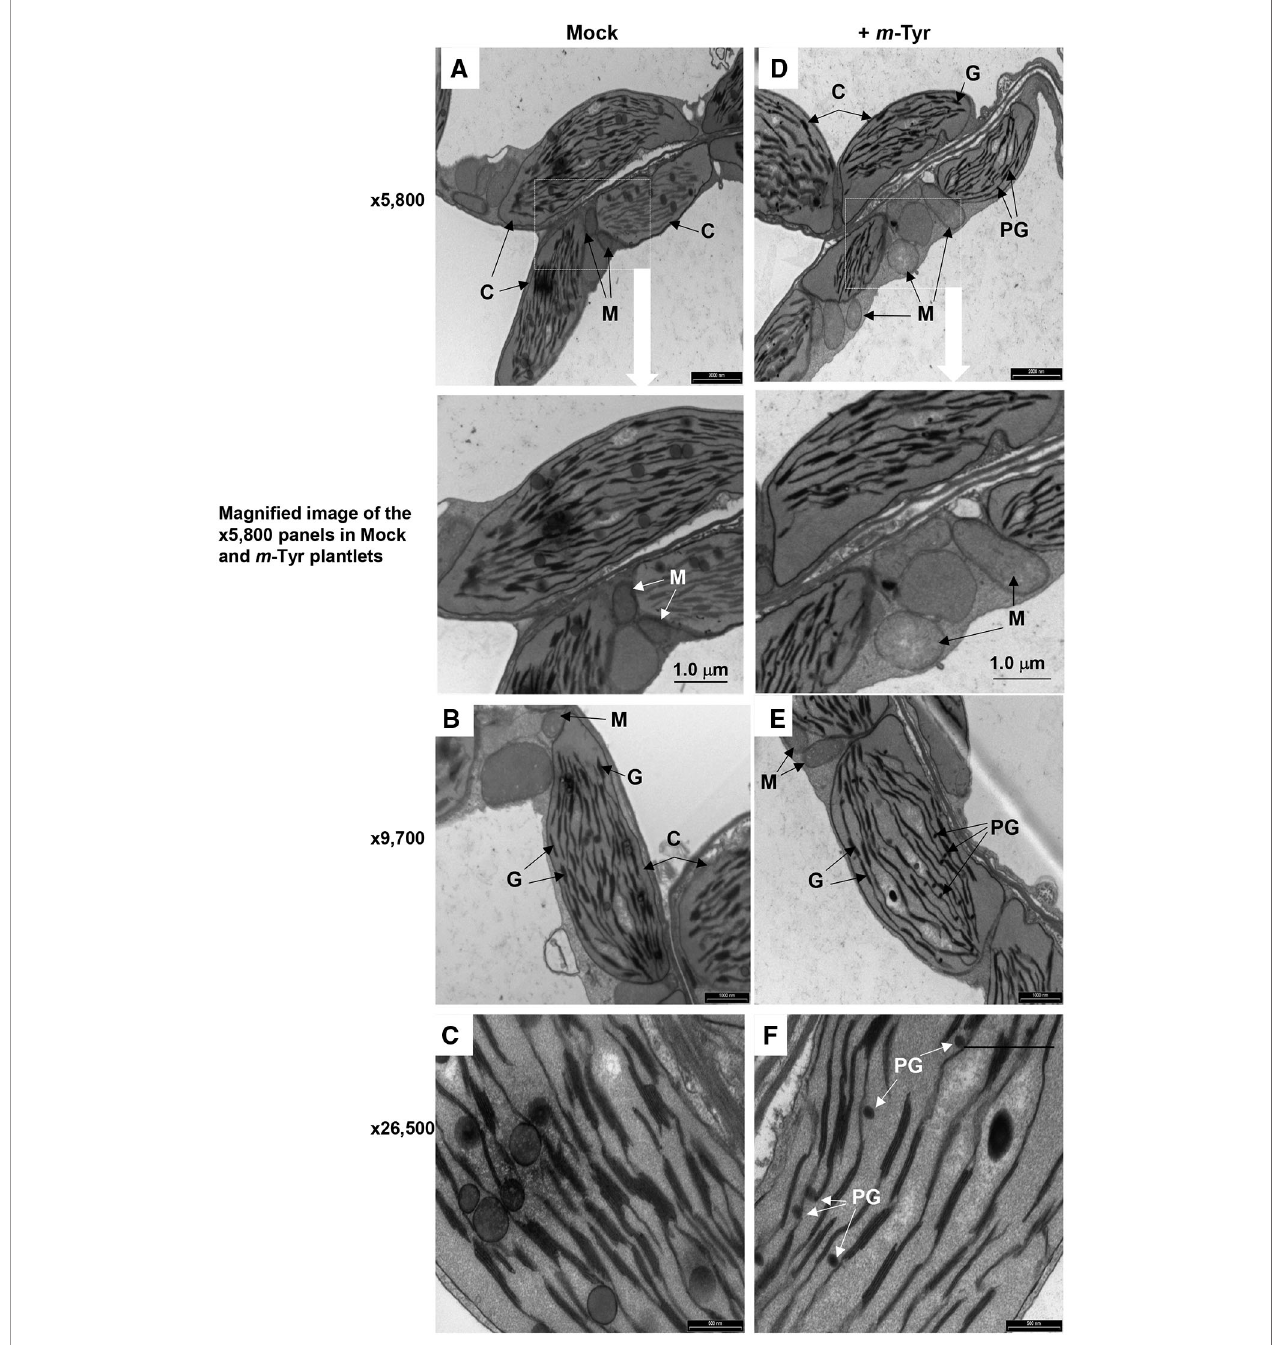
FIGURE 4 | The effect of m -tyrosine on organellar morphologies in Arabidopsis plants. Representative transmission electron micrographs of ultrathin sections from the hypocotyl tissue of 5-day-old Arabidopsis seedlings seeded on Murashige and Skoog (MS)-agar plates in the absence (panels A – C ) or presence of 10 m M m - tyrosine (panels D – F ). Mitochondria are labeled by “ M, ” “ C ” indicates to chloroplasts, “ G ” refers to grana stacks, while plastoglobuli are labeled as “ PG. ” Bars represent 2 µm in panels A , D , 1.0 µm in panels B , E , and 0.5 µm in panels C , F , as indicated in each